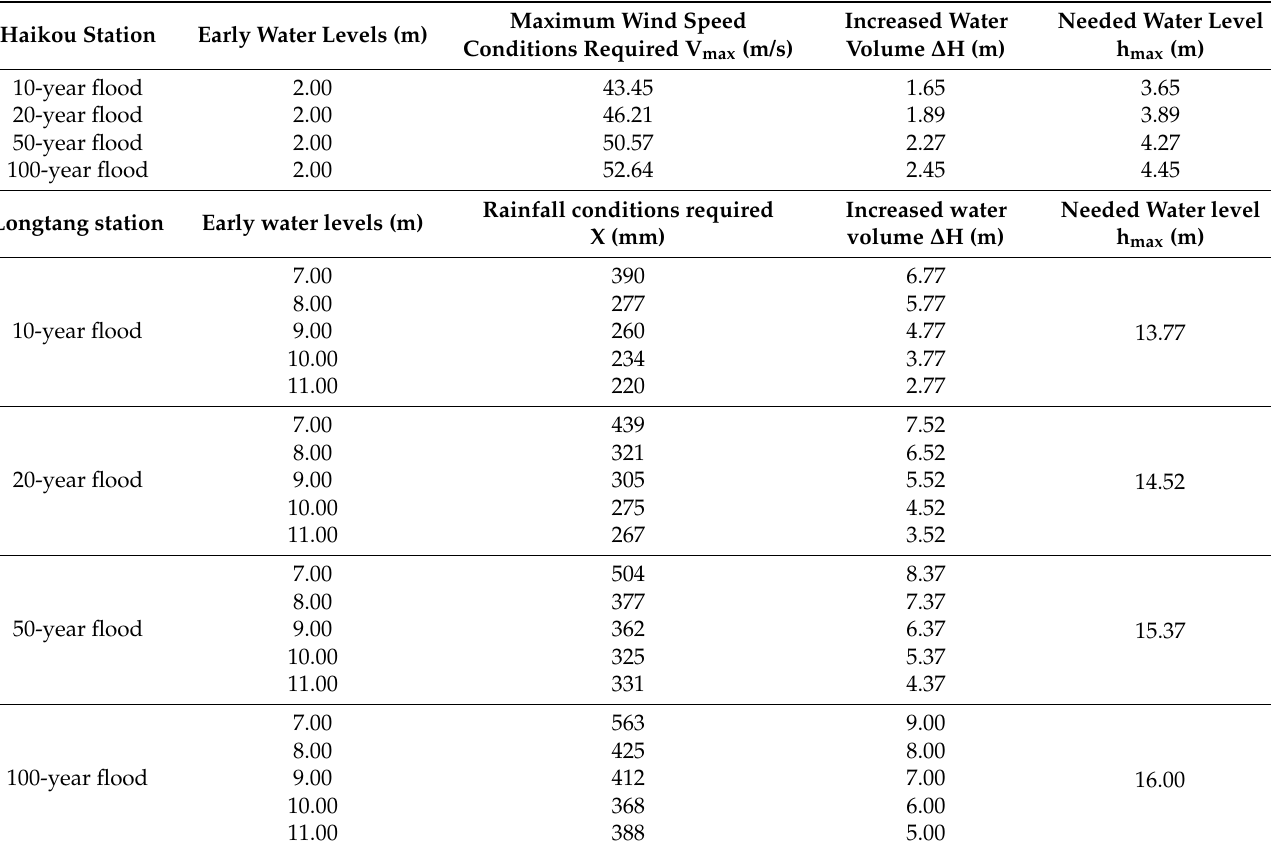
Table 2. Typhoon and rainstorm threshold to reach different flood (tide) levels under different early water